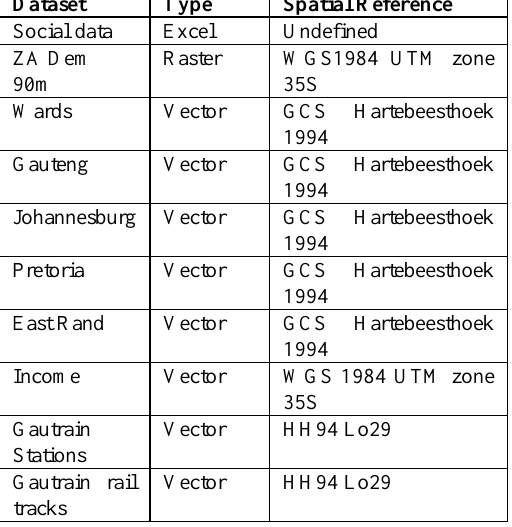
Figure 5: Dataset